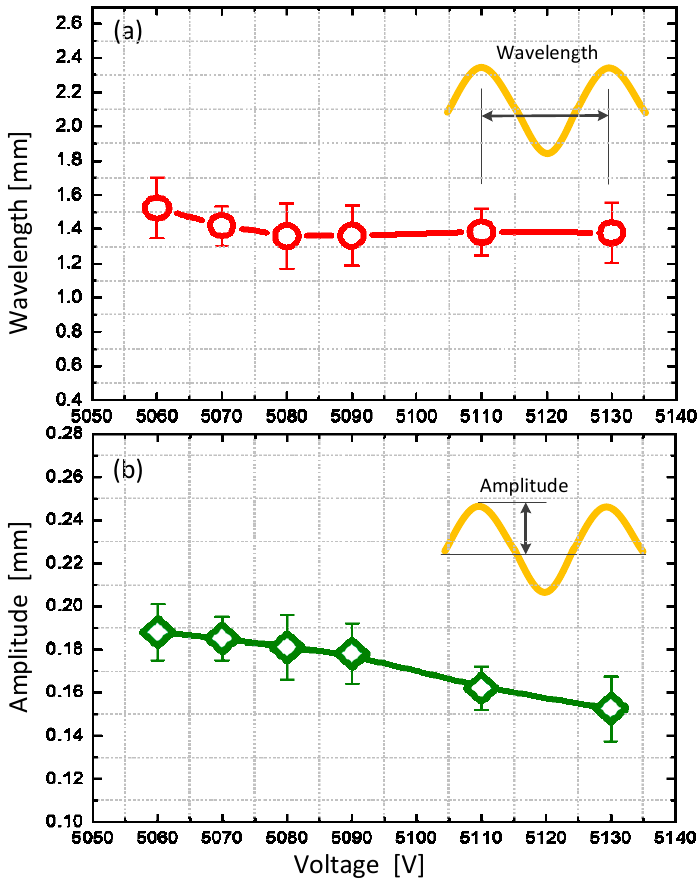
Figure 7. Voltage tuned wrinkling morphology of the hydrogel in ( a ) wavelength and ( b ) amplitude.